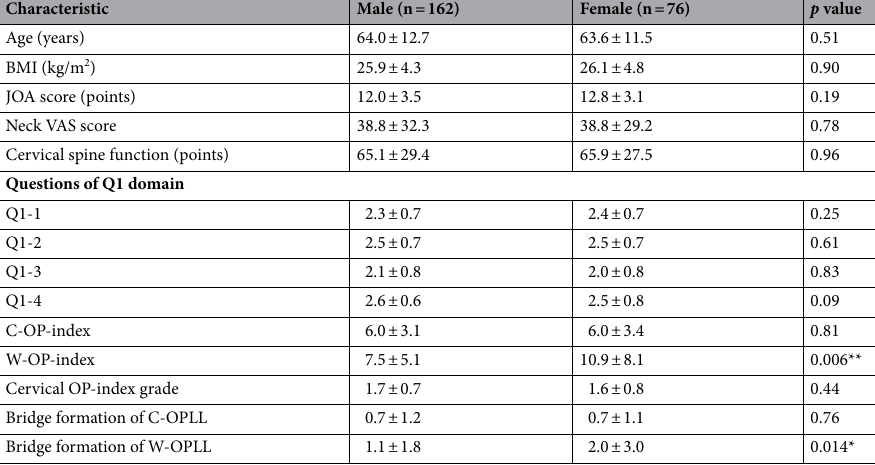
Table 2. Sex differences in parameters. Data are presented as mean ± standard deviation. BMI body mass index; JOA Japanese Orthopaedic Association; VAS visual analog scale (100-mm). Q1 domain, cervical spine function domain of the Japanese Orthopaedic Association Cervical Myelopathy Evaluation Questionnaire; C , cervical; W , whole spine; OP-index Ossification index for OPLL; bridge formation, ossified lesions forming a bridge with the posterior border of the adjacent vertebral body. * p < 0.05; ** p <